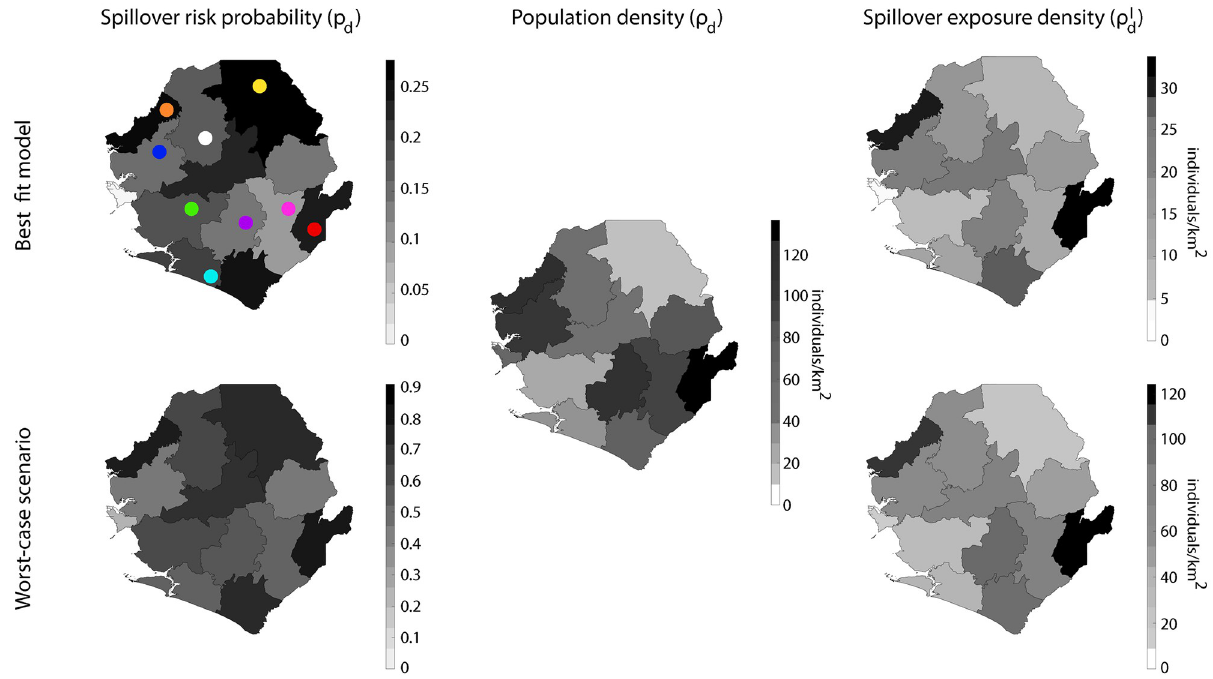
Fig 6. Estimation of the infection spillover map in Sierra Leone by districts. From left to right the figure shows the spillover risk probability ( p d ), the population density ( ρ d ), and the infection spillover exposure ( r I ) respectively. In the case of p d and ρ d the maps showed on the top stand for the cases of d the best fit logistic model and on the bottom the worst-case scenario (see text). District color codes (as shown on top left): Bo (purple), Bombali (white), Bonthe (cyan), Kailahum (red), Kambia (orange), Kenema (pink), Koinadugu (yellow), Moyanba (green), and Port Loko